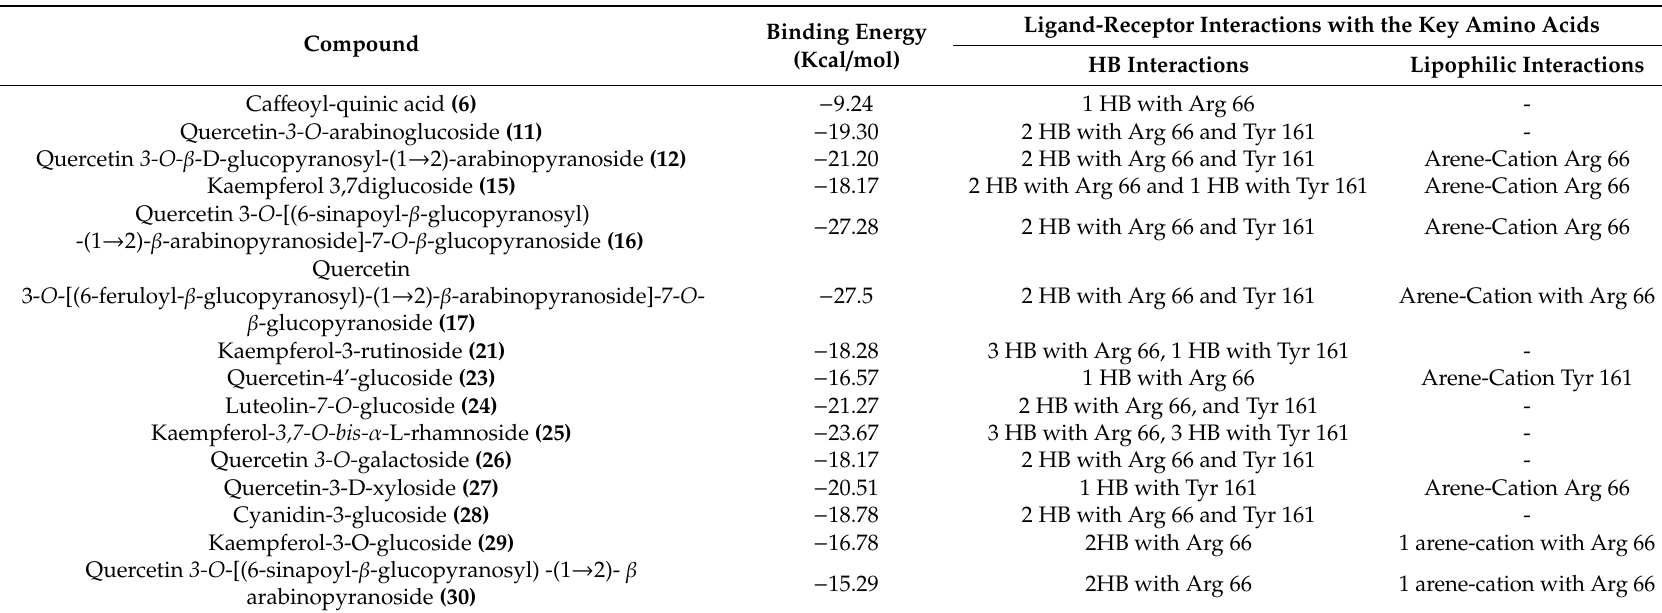
Bolded numbers in parenthesis represent the number of the chemical structure (Figure